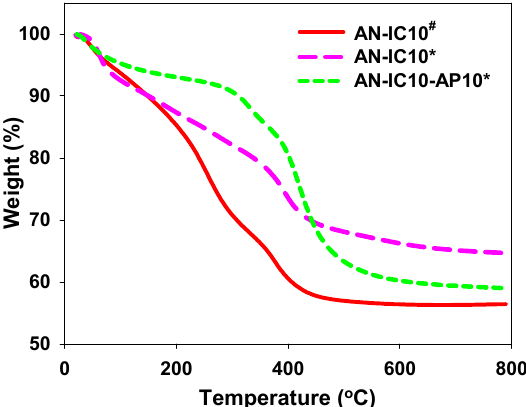
Figure 2. TG profiles of the as-synthesized ( # ) alumina–silica sample with isocyanurate bridging groups and alumina–silica samples with isocyanurate bridging groups in the presence and absence of aminopropyl groups after the extraction and calcination (*). Note that AN and AP refer to the aluminum nitrate and aminopropyl, respectively.